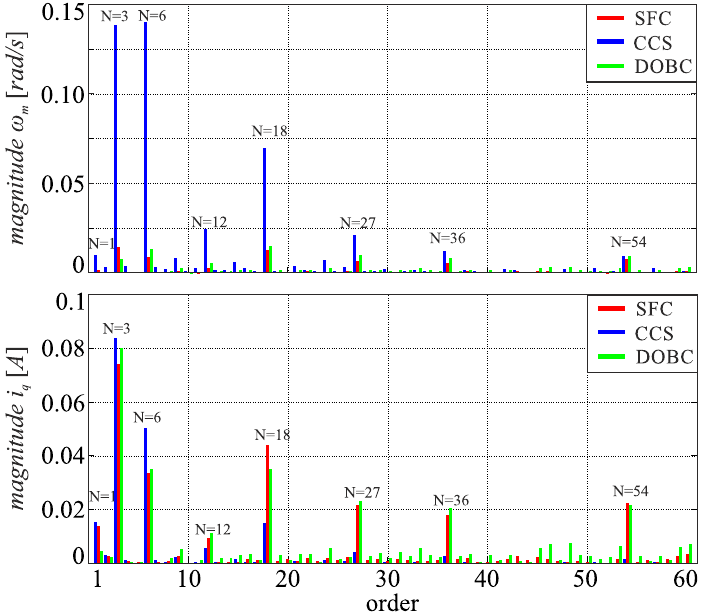
Figure 11. Frequency spectrum of angular velocity and quadrature current component for a set reference of 5 rad/s and constant load 3 Nm.